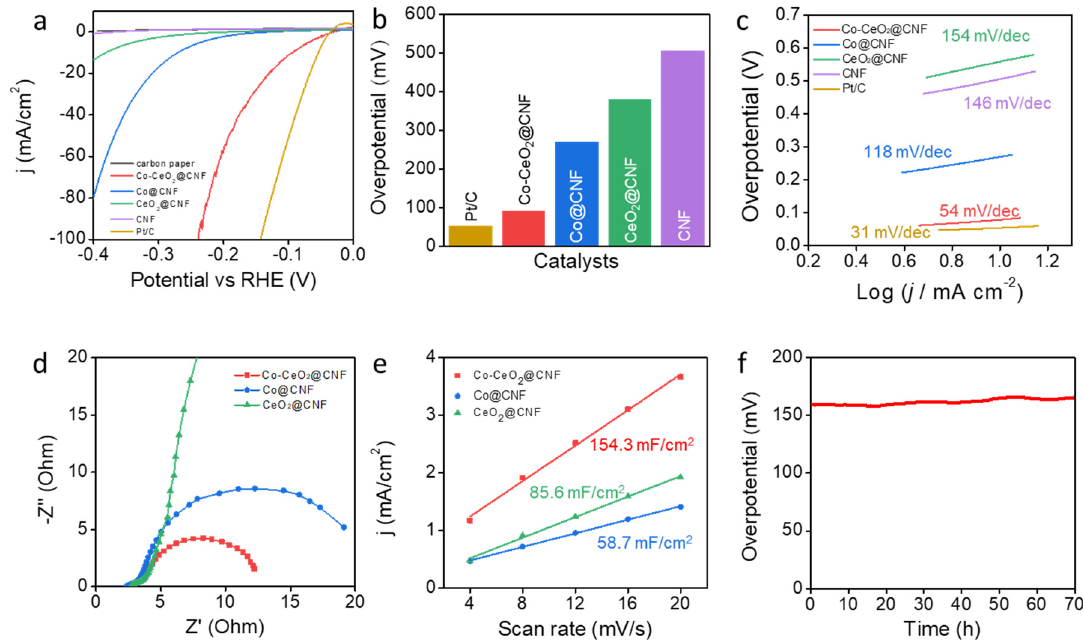
Figure 2. Electrochemical performances of the electrocatalysts for the HER in 1-M KOH. ( a ) HER polarization curves of the Co-CeO 2 @CNF, Co@CNF, CeO 2 @CNF, CNF, commercial Pt/C, and bare